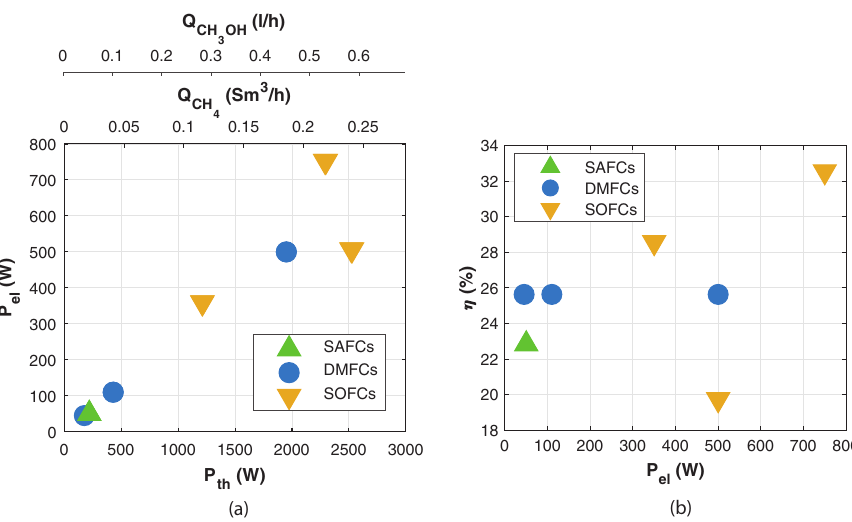
Figure 4. Power levels ( a ) and nominal efficiencies ( b ) of